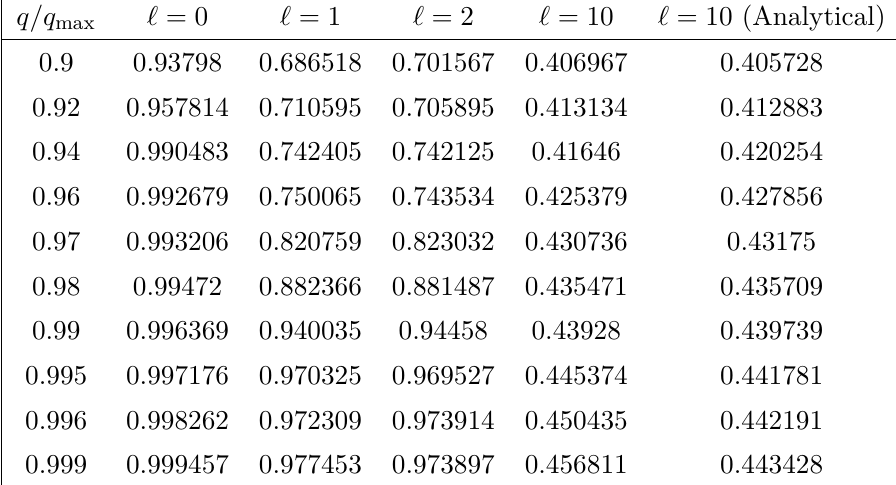
Table 5 . Numerical values of {− ( Im ω n,l ) /κ − } have been presented for different choices of angular momentum ‘ . Here we have considered the value of the cosmological constant to be Λ = − 0 . 1 and mass M = 1 , respectively.